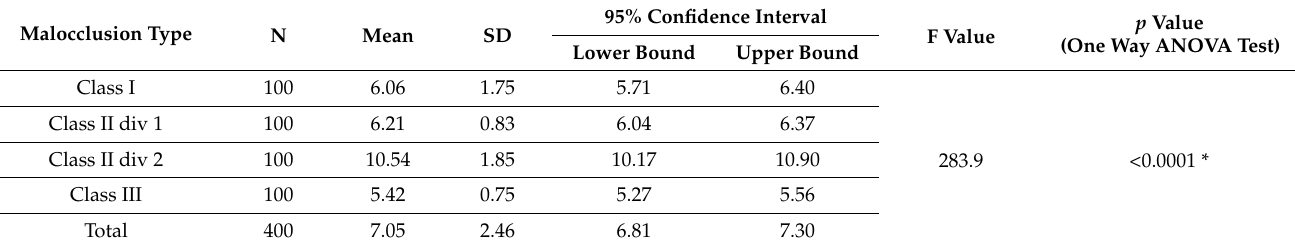
Table 1. Mean CA of maxillary central incisor in different malocclusion types (shown in degree).